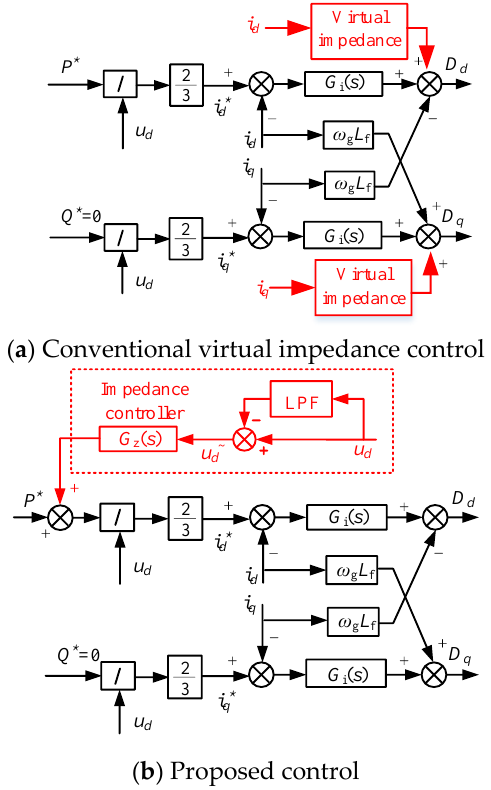
Figure 8. Control scheme of impedance-reshaped stability-enhancing control.